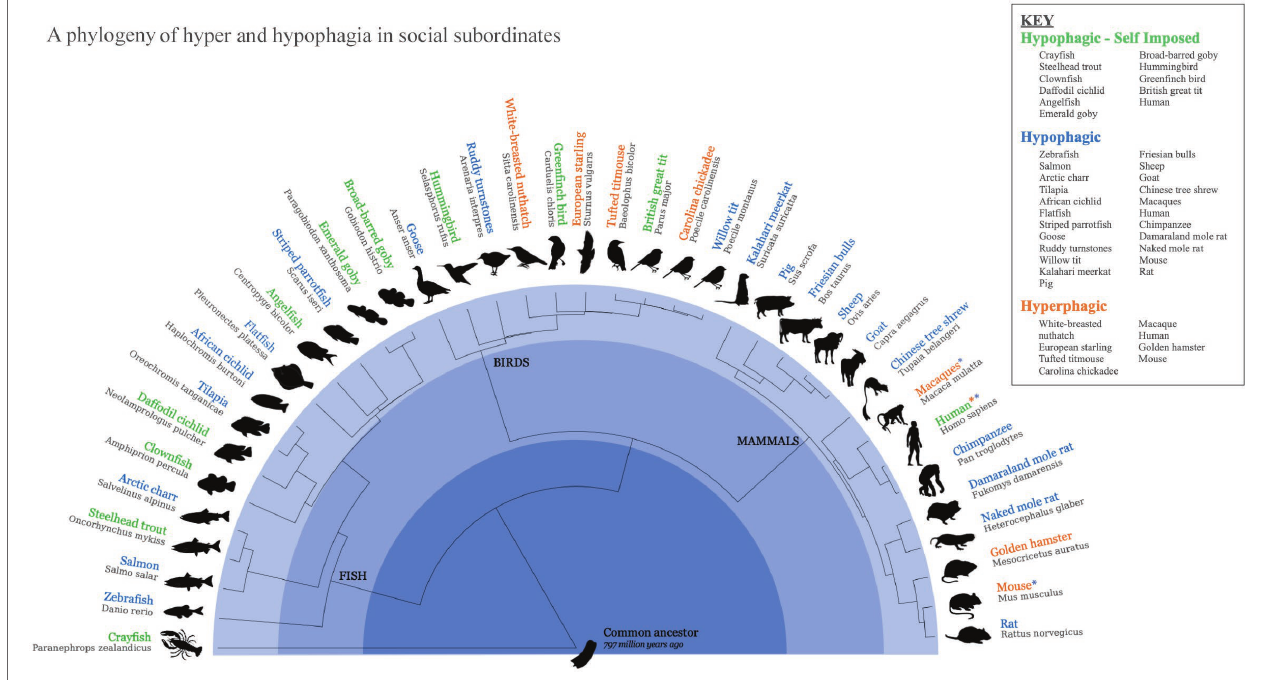
FIGURE 1 | Animal models for hypophagia and hyperphagia in socially subordinated animals. A phylogeny of the potential naturally occurring animal models for hyperphagic and hypophagic responses to social stress. References: Hypophagia - Self Imposed (Abbott and Dill, 1989; Ekman and Hake, 1990; Hiebert,